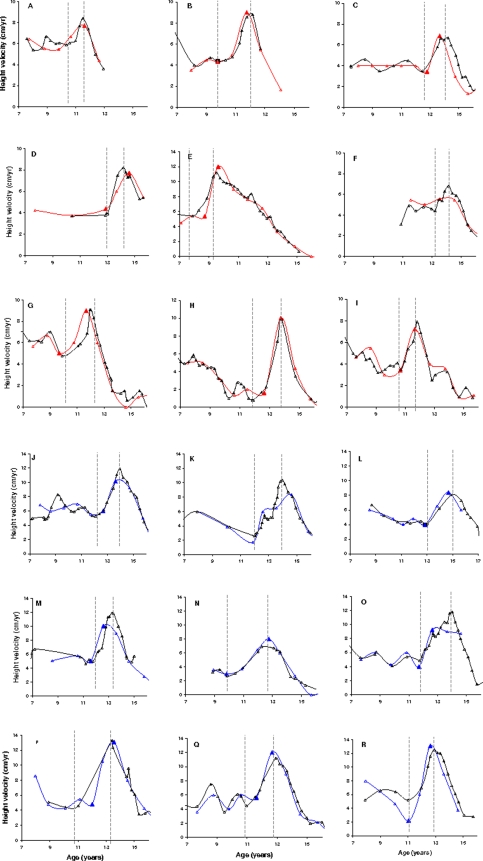
Height velocity curves in 9 girls and 9 boys from the validation of the method.Height velocity curves in a subset of 9 girls (A–I) and 9 boys (J–R) from the validation of the method. The complete set of measurements and the randomly selected annual measurements are illustrated with indications of age at onset and PHV judged by both visual and computerized methods independent of each other. Note Figure 1F and 1K, where ages at onset and PHV were not determined by computation. These children were recorded as having reached onset of pubertal growth and PHV, but the yearly measurement was too sparse to determine the pubertal growth. By looking at the complete set of measurements there was no doubt that all these children had reached onset and PHV and the interval censoring of these children was thus fully acceptable.